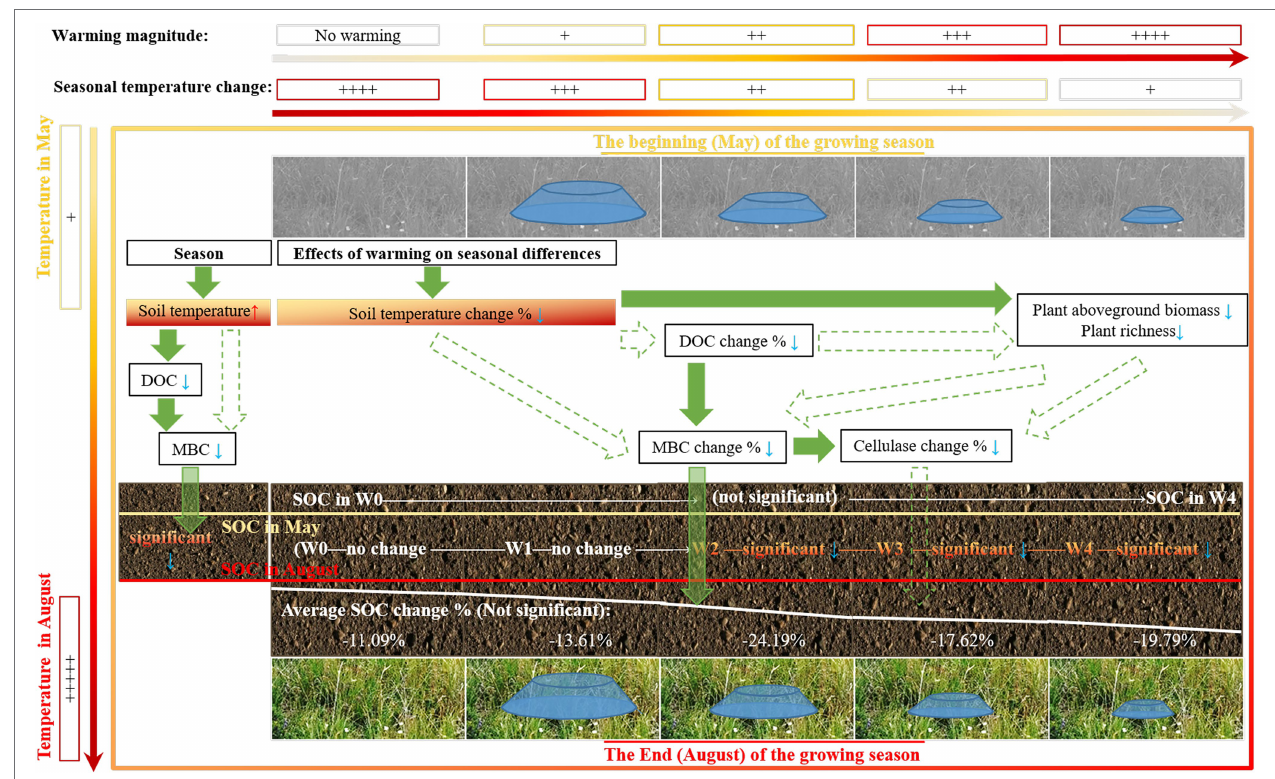
FIGURE 6 | Schematic representation of the effect of experimental warming on the change of soil organic carbon during the growing